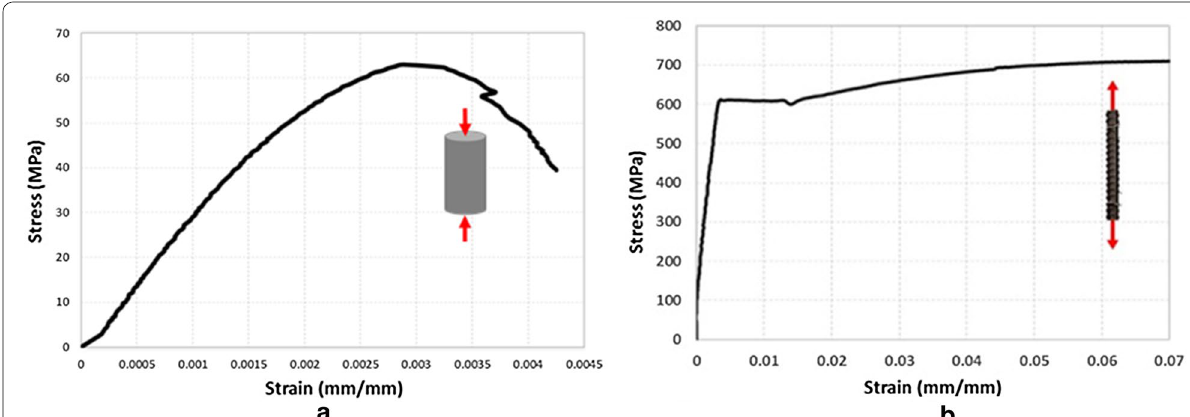
Fig. 1 Stress‑strain behavior a normal concrete, b shear reinforcement.